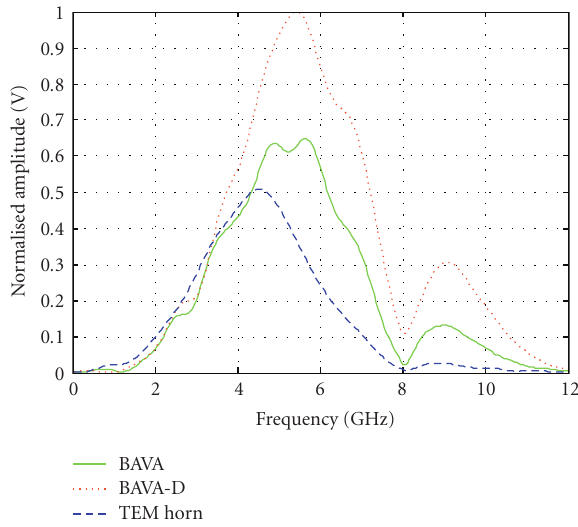
Figure 11: Frequency domain reflections from tumor recorded with each of the three antennas.